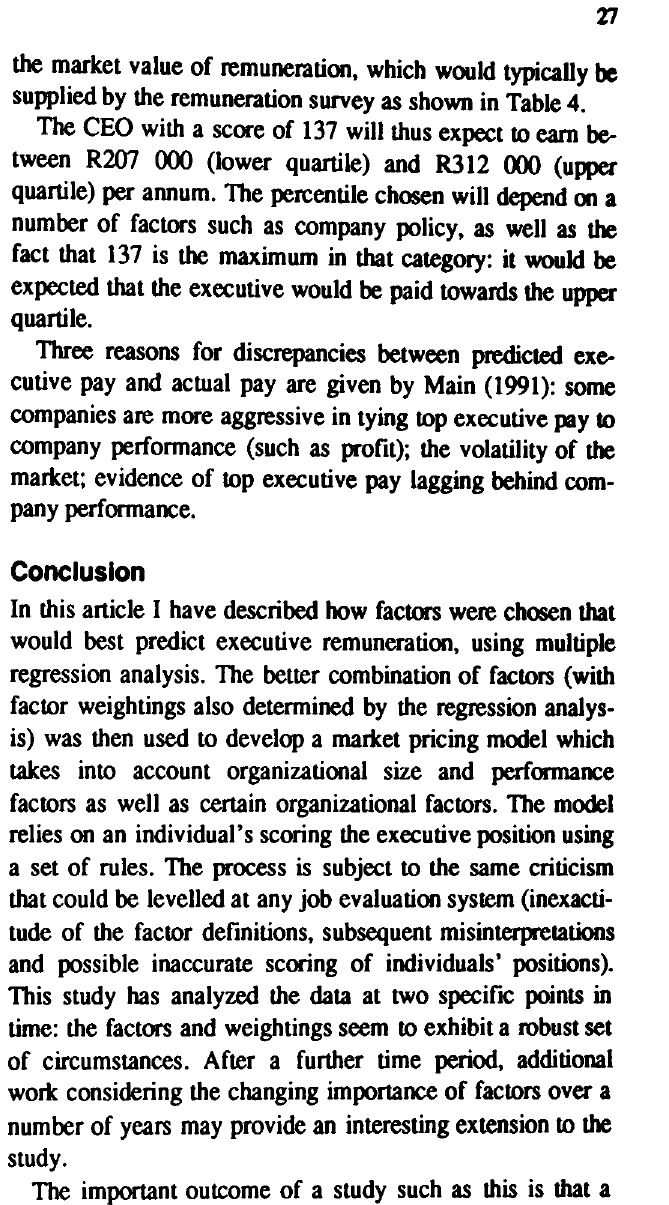
Table 2 Regression coefficient values